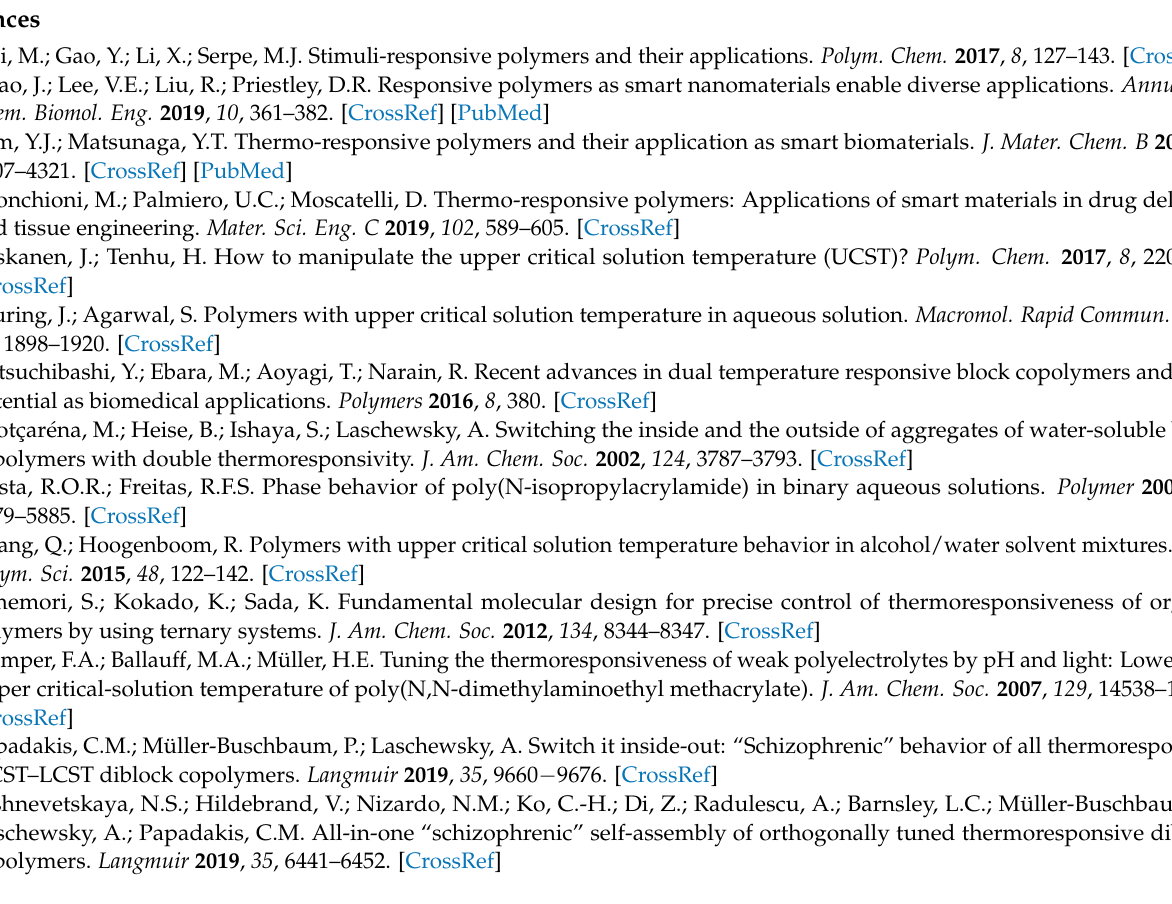
Figure S22: FT-IR spectra of the dendrimers synthesized in this study. Figures S23–S25. Temperature- dependent transmittance curves of dendrigraft polylysine in different pHs, PAMAM-Phe-Suc and PAMAM-Phe-SO 3 Na in H 2 O and D 2 O buffers, and PAMAM-Phe-CHex and PAMAM-Phe-SO 3 Na at different dendrimer